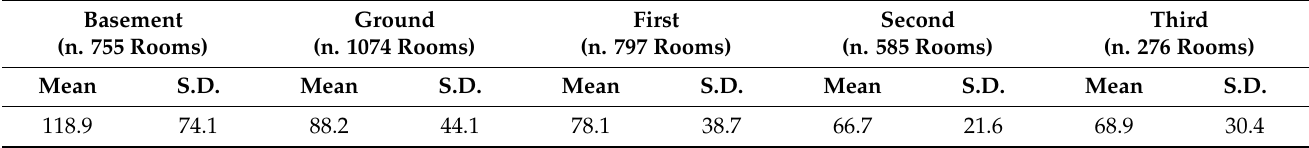
Table 1. Annual radon concentration in the different floors (Bq/m 3